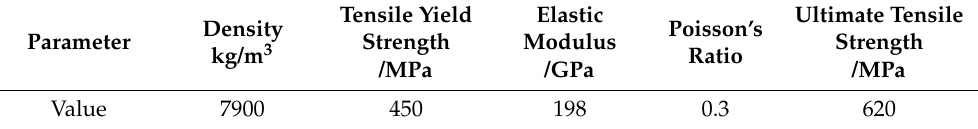
Table 2. Parameters of anchor.